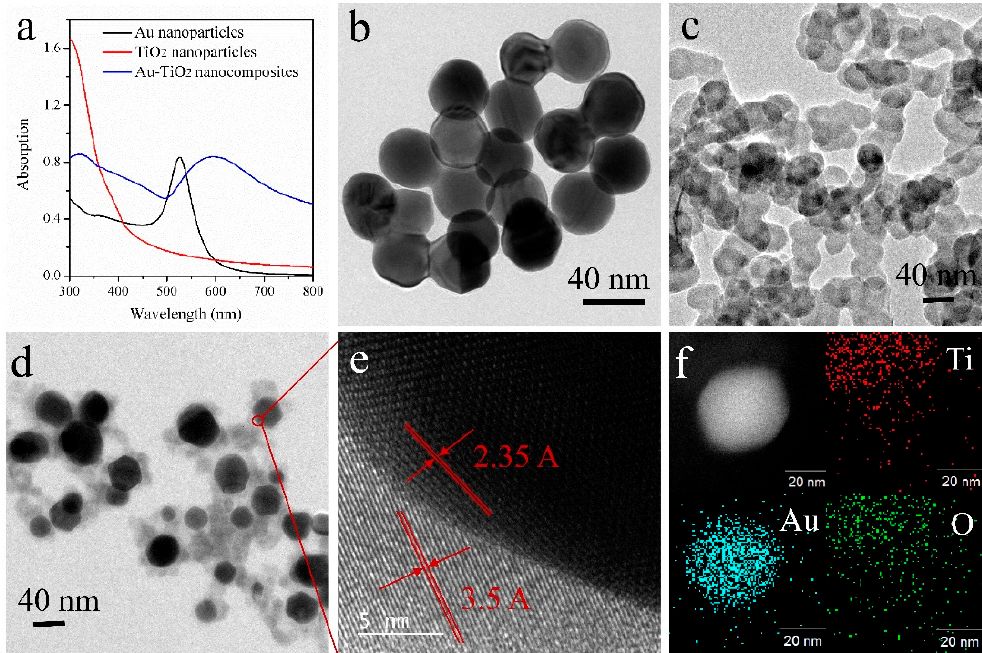
Figure 1. ( a ) UV–vis absorption spectra of the Au NPs, TiO 2 NPs and Au-TiO 2 nanocomposites films; TEM images of ( b ) Au NPs, ( c ) TiO 2 NPs, and ( d – f ) Au-TiO 2 nanocomposites.